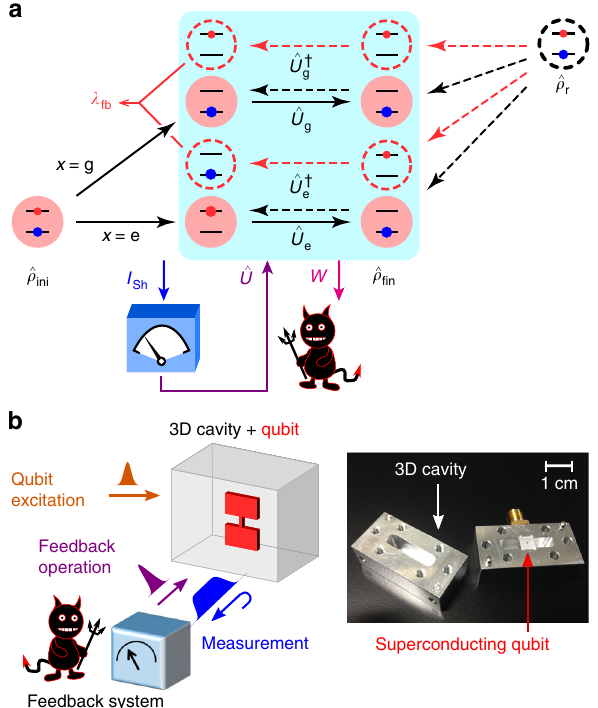
Fig. 1 Maxwell ’ s demon and absolute irreversibility. a Concept of the experiment. The system initially prepared in a canonical distribution ^ ρ ini evolves in time. A projective measurement [with outcome x ( = g or e)] by the demon projects the system onto a quantum state. The demon gains the stochastic Shannon entropy I Sh and converts it into work W via a feedback operation ^ U ( ¼ ^ U g or ^ U e ). The forward process ends up in the fi nal distribution ^ ρ . The time-reversed reference process starts from a fin reference state ^ ρ , which we choose to be equal to ^ ρ . The absolute r ini irreversibility is quanti fi ed with λ fb , the probability of those events in the time-reversed process whose counterparts in the original process do not exist (red dashed arrows). b Schematic of the feedback-controlled system in the experiment. The right panel shows a photograph of the qubit- resonator coupled system. The cavity resonator is disassembled to show